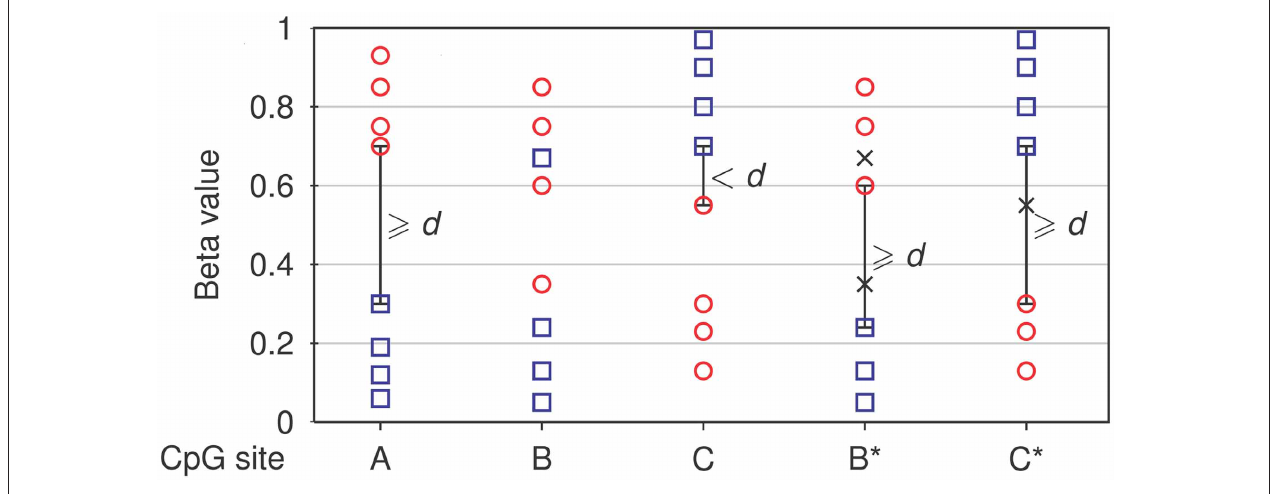
FIGURE 1 | Detection of differential methylation by NIMBL. Each site is tested for a minimum distance of beta values ( d ) between two groups (corresponding samples depicted as circles and squares). If no samples are masked ( m = 0), only non-overlapping